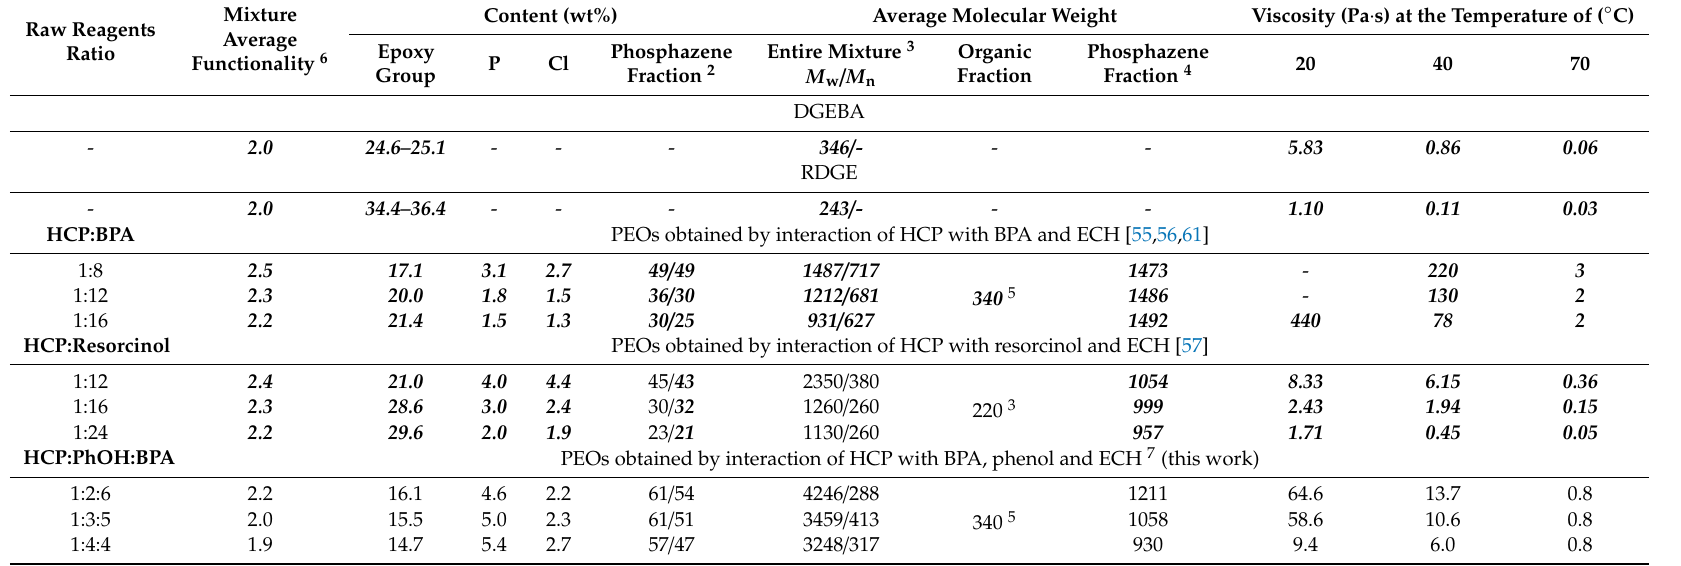
Table 3. The properties of phosphazene-containing epoxy oligomers 1